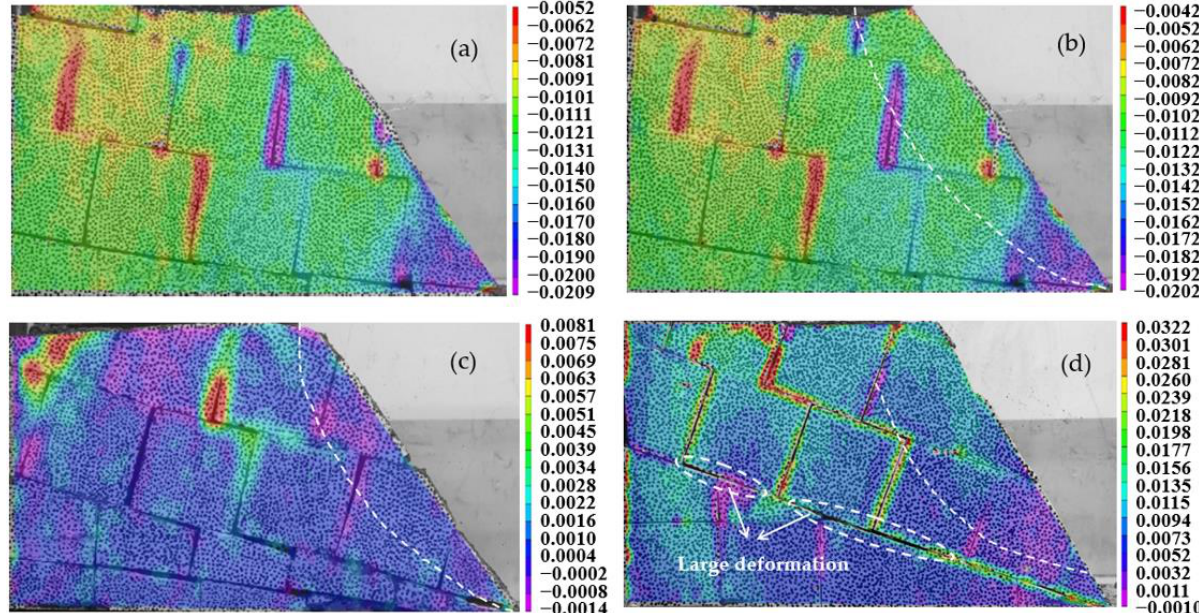
Figure 12. Strain contours of the slope model with crack networks at an angle of 10° and 20° under different loadings. ( a ) Under 1.6 MPa at 10°; ( b ) under 16 MPa at 10°; ( c ) under 1.6 MPa at 20°; ( d ) under 16 MPa at 20°.